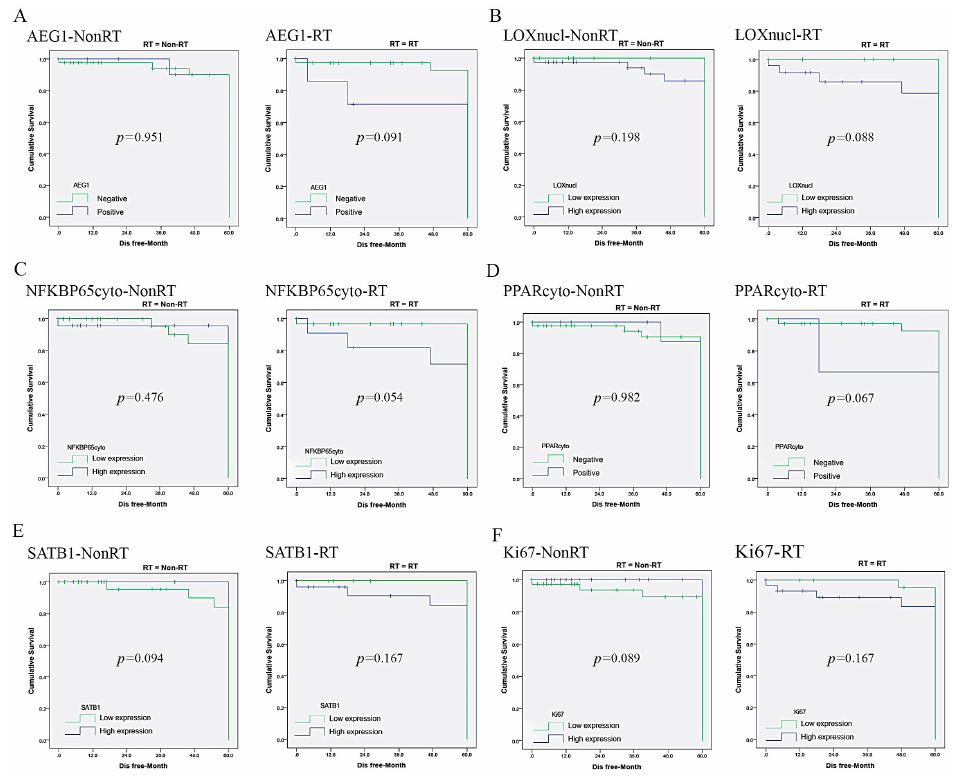
Figure 3. The patients with the high expression of: AEG1 ( A ); LOXnucl ( B ); NFKBP65cyto ( C ); PPAR cyto ( D ); SATB1 ( E ); and Ki67 ( F ), in BS tended to benefit from RT for DFS.